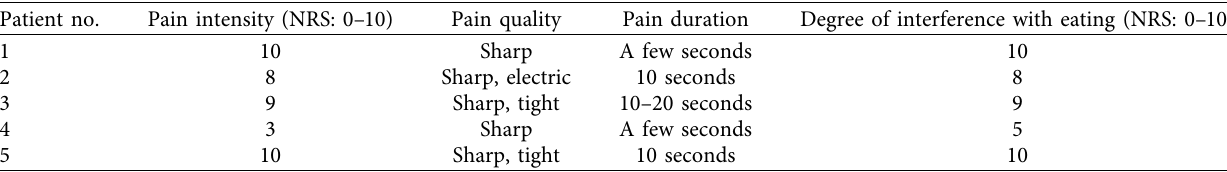
MRI, magnetic resonance imaging; TMJ, temporomandibular joint. Table 4: Pain-related characteristics in patients with idiopathic first bite syndrome. Patient